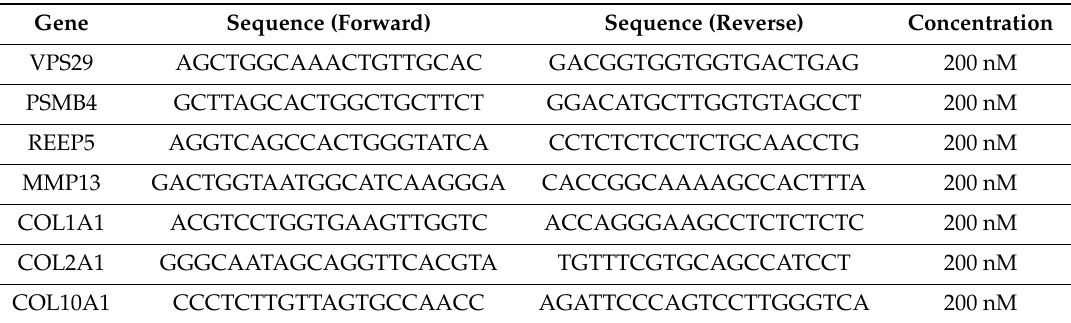
Table 2. List of primers. Genes are abbreviated according to the NCBI gene database. Gene Sequence (Forward) Sequence